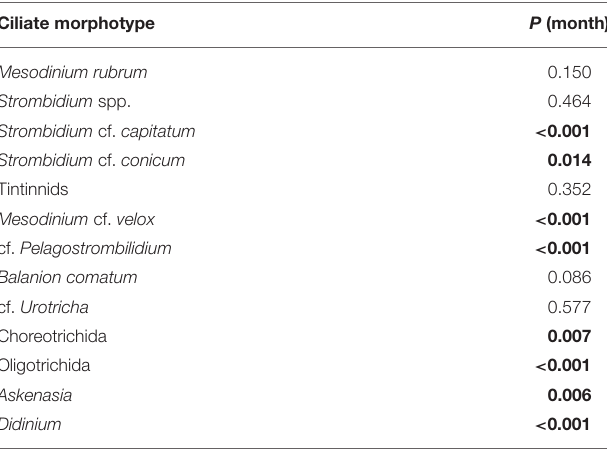
TABLE 3 | Seasonality test for the log-transform of carbon biomass of different ciliate morphotypes. Ciliate